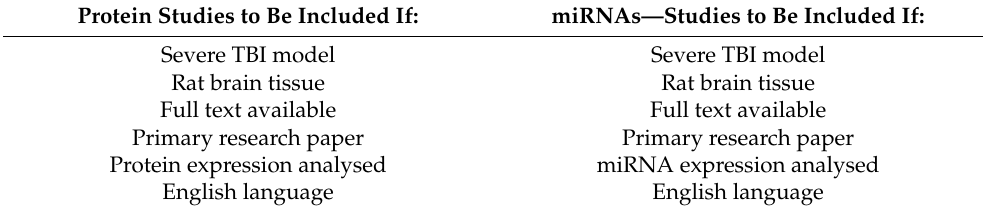
Table 1. Inclusion criteria.